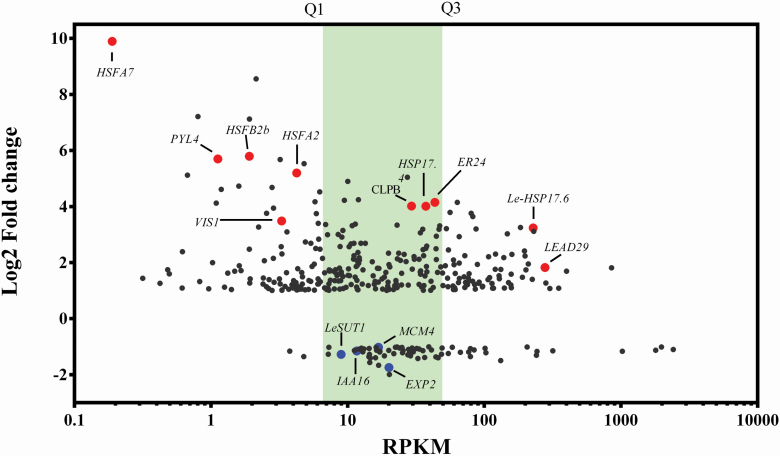
Dispersion between abundance (RPKMs, x-axis) and degree of expression (log2 fold change, y-axis) of up- (●) and down-regulated genes (●) identified. Each point represents differentially expressed genes. Green shade indicates division between low, medium and high abundance, defined using quartiles (Q1 and Q3).